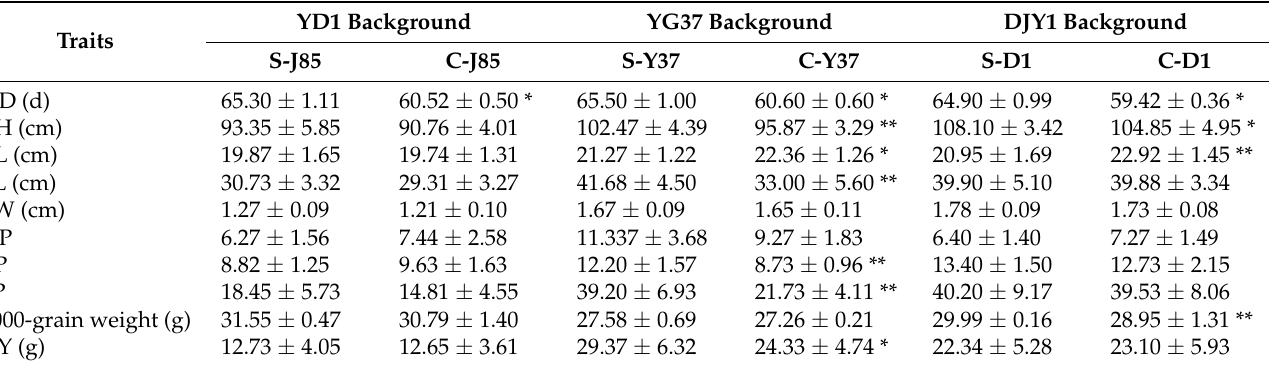
Table 6. Investigating the agronomic traits of seed seedlings and cuttings from ILs/NILs in different backgrounds.